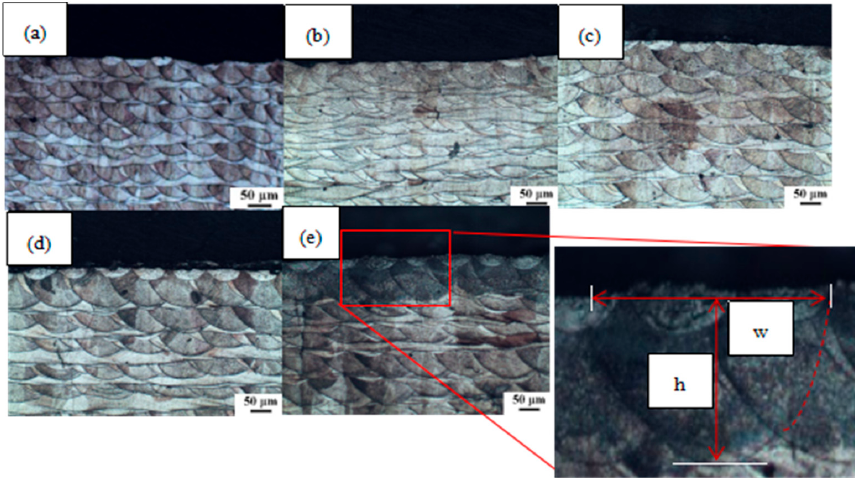
Figure 5. Metallographic structure of the sample at different laser powers: ( a ) 140 W; ( b ) 180 W; ( c ) 220 W; ( d ) 260 W; ( e ) 300 W.